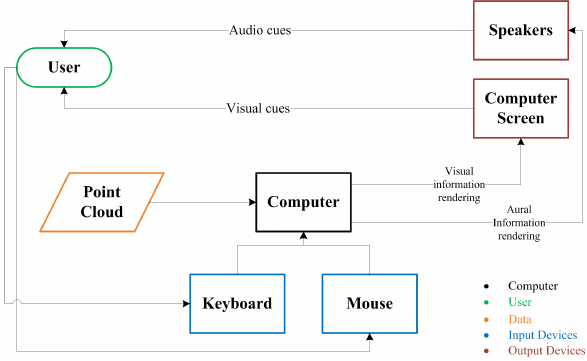
Figure 1: Audio augmentation in coarse scan registration.